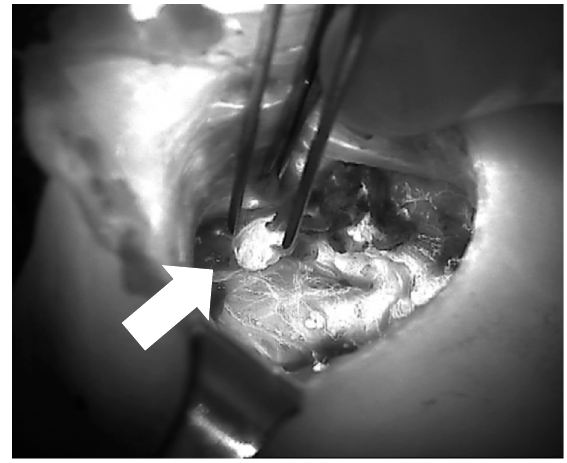
Figure 7. Image of parathyroid ICG angiography (of the right superior parathyroid after thyroidectomy) showing a well-vascularized parathyroid gland between the forceps (arrow).